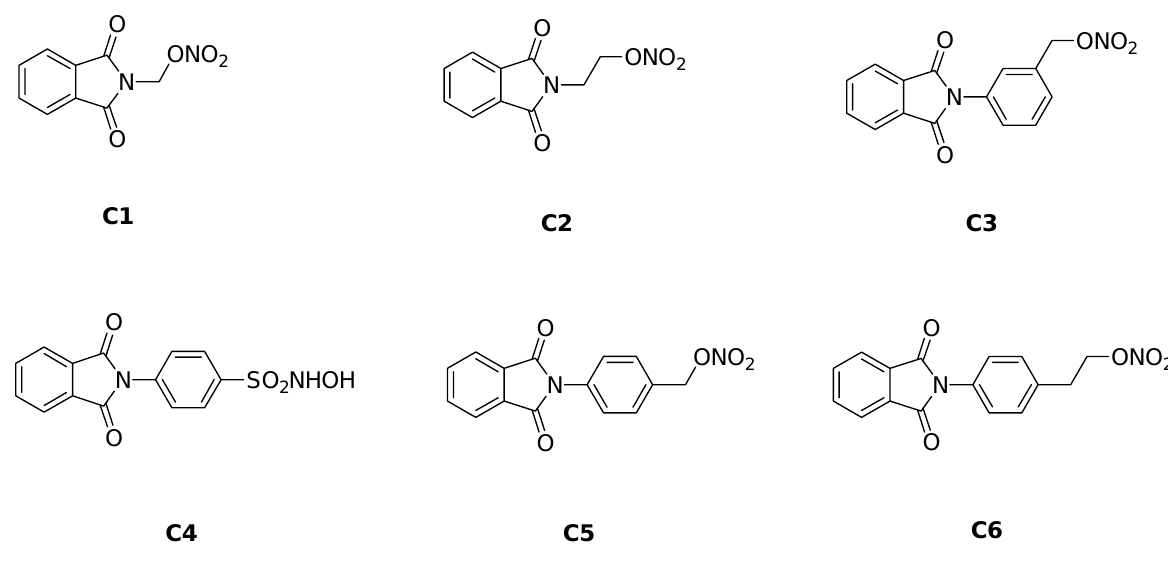
Figure 1. Chemical structures of compounds C1-C6